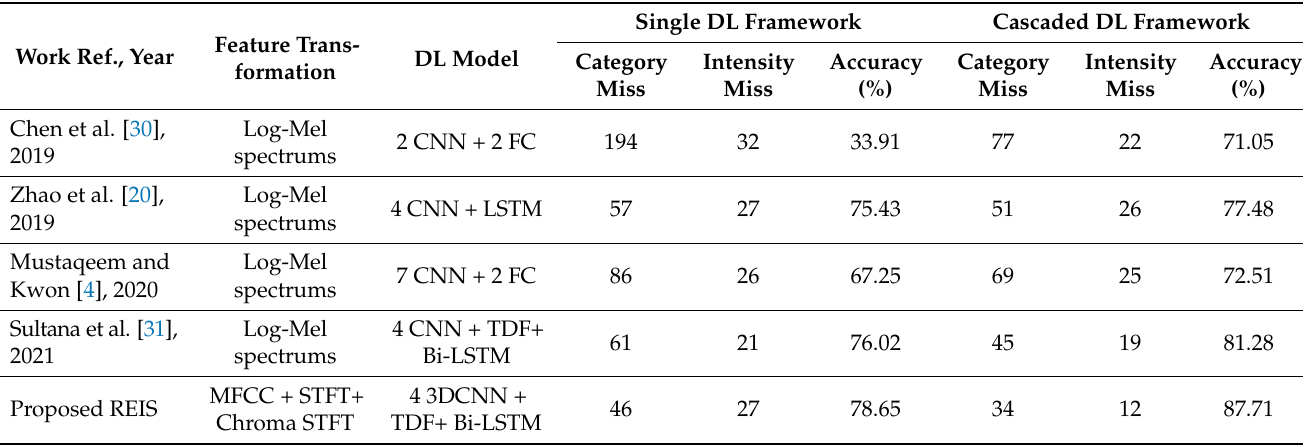
Table 7. Performance (i.e., test set accuracy) comparison with State-of-the-arts for emotion recognition with intensity